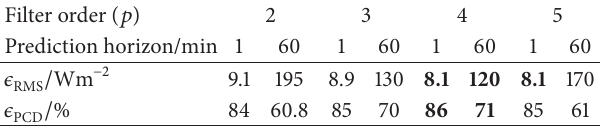
Table 4: Solar radiation prediction results for a three- state MARM. Filter order ( 𝑝